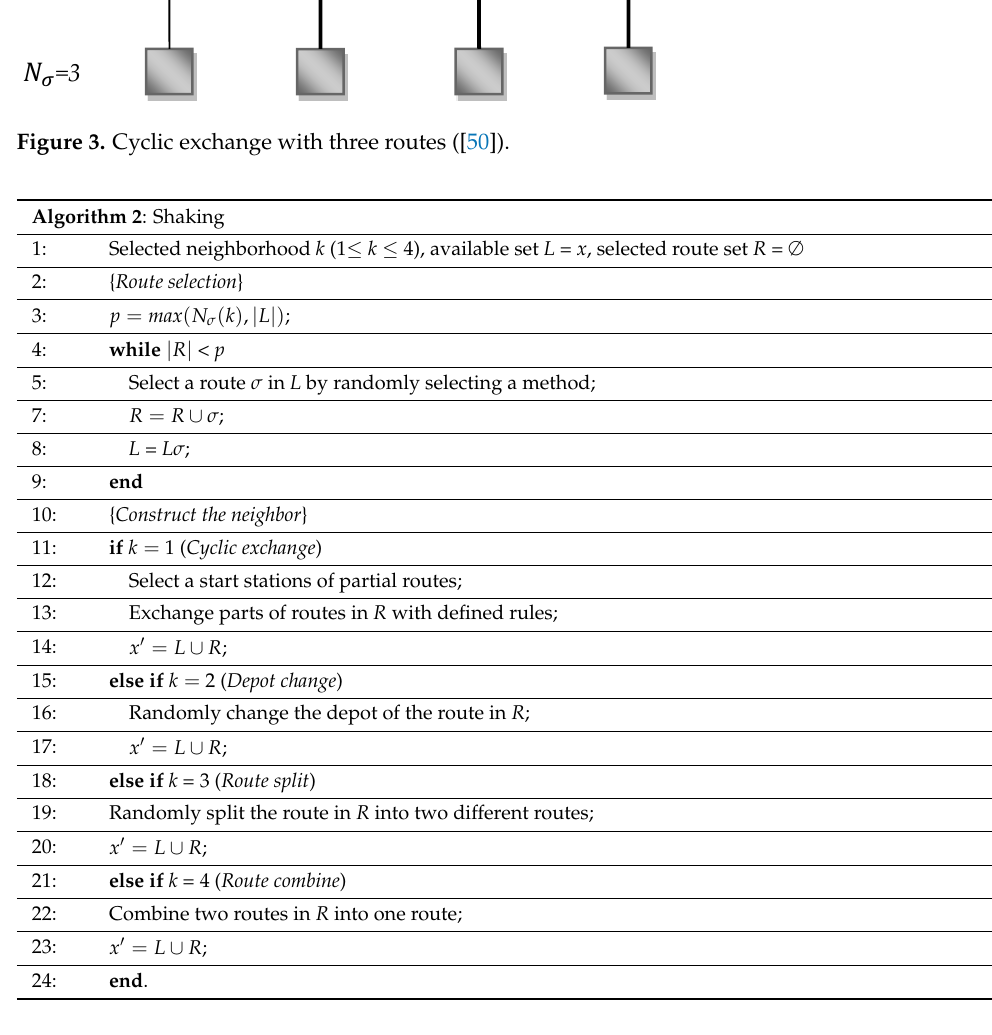
Figure 5. Illustration example of route split.